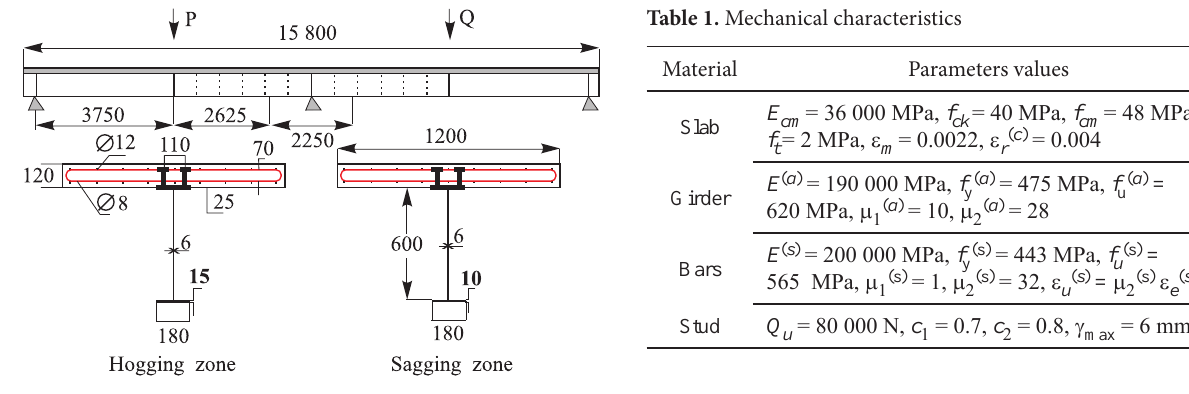
Fig. 5. Geometrical characteristics of the twin-beam